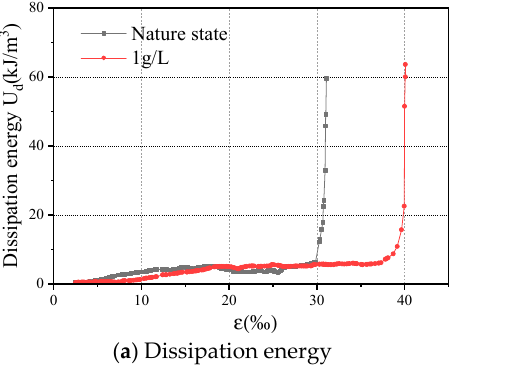
Figure 5. The changes in the energy curves.